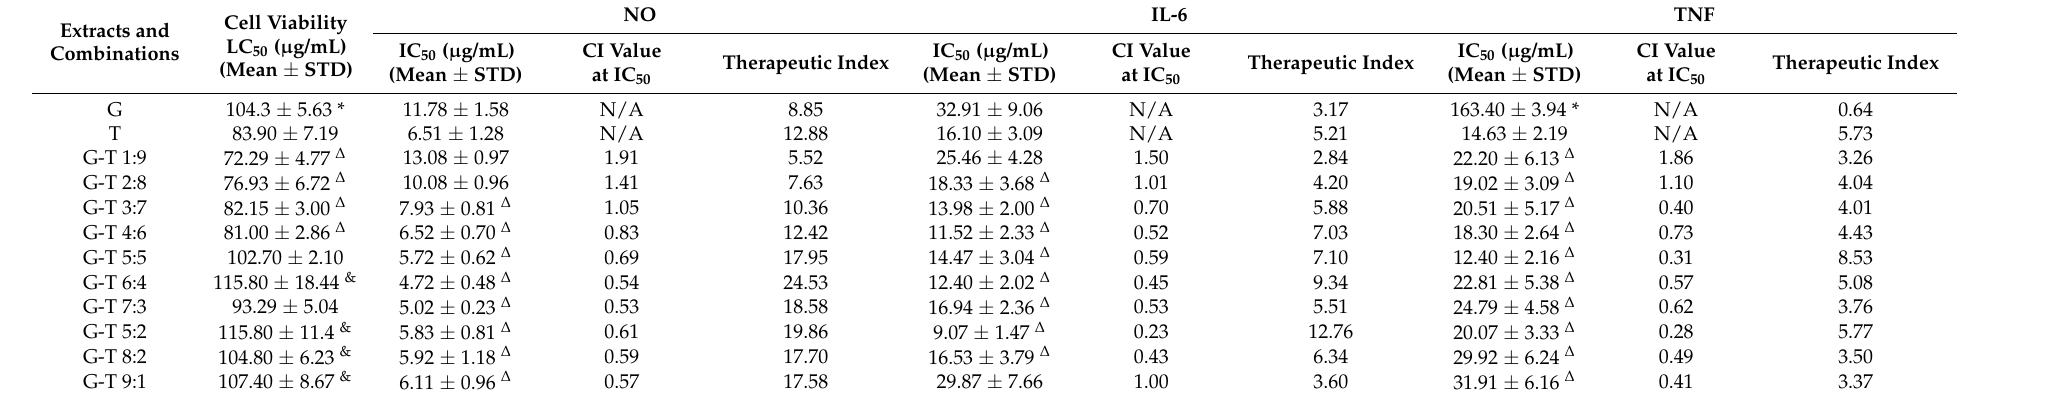
Table 1. Anti-inflammatory activity, synergistic interaction, therapeutic index and cytotoxicity parameters of ginger extract (G), turmeric extract (T) and G-T combinations in inhibiting LPS-induced NO, IL-6 and TNF productions in RAW 264.7 cells ( n > 3 of